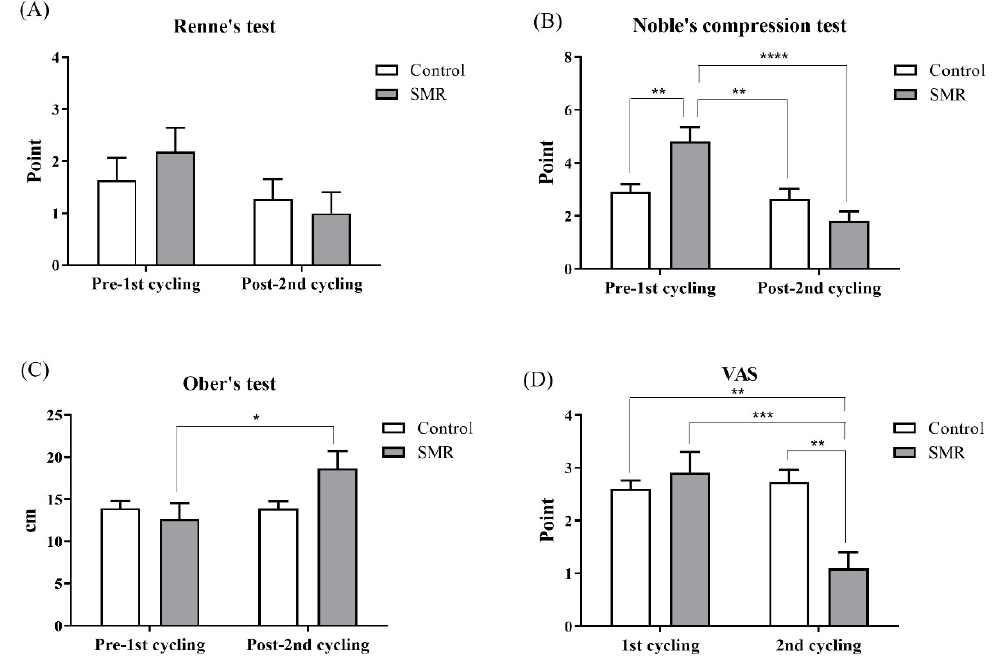
Figure 2. Comparison of iliotibial band flexibility and visual analog scale. ( A ) Results of the Renne’s test; ( B ) Results of the Noble’s compression test; ( C ) Results of the Ober’s test; ( D ) Results of the visual analog scale test. * Superscripts denote statistically significant values (* p < 0.05; ** p < 0.01; *** p < 0.001; **** p < 0.0001).